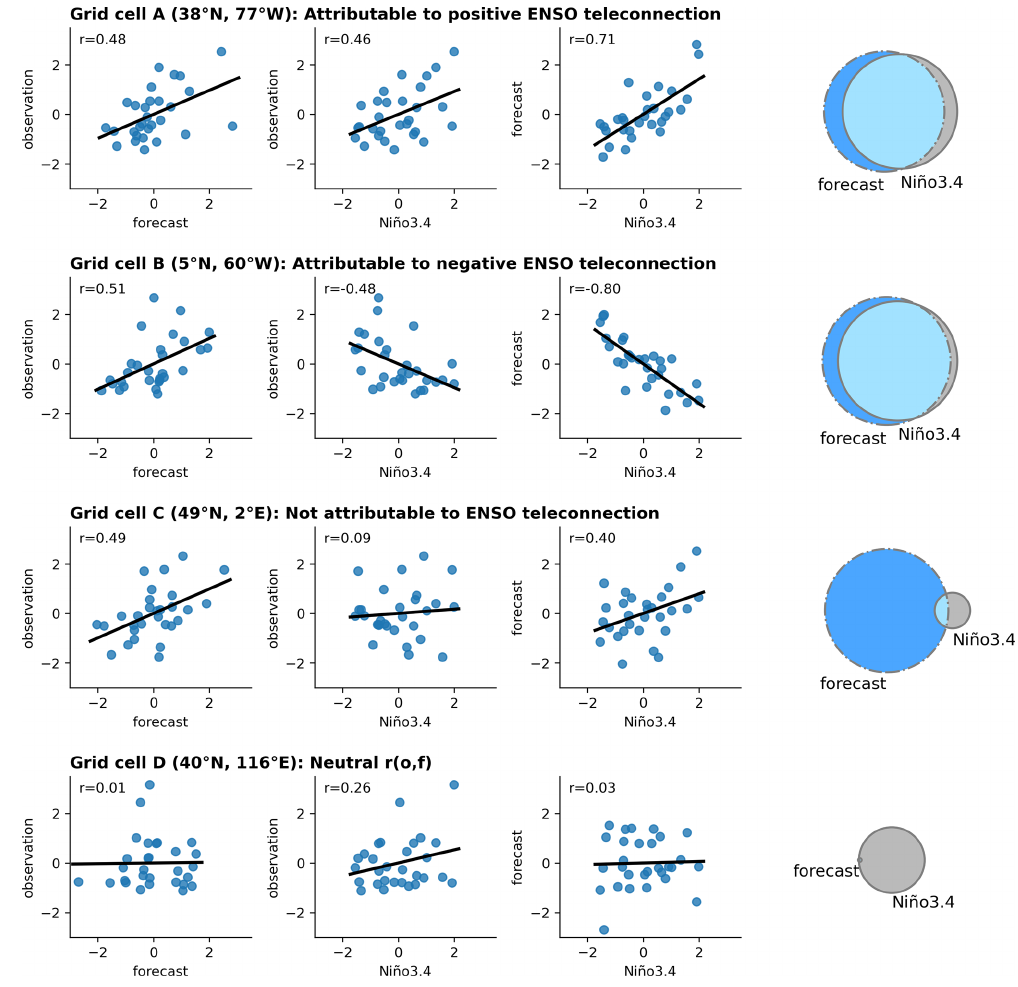
Figure 8. Scatter plots of the relationships between normalized observation, forecast and Niño3.4 and Venn diagrams of the union and intersection operations for four selected grid